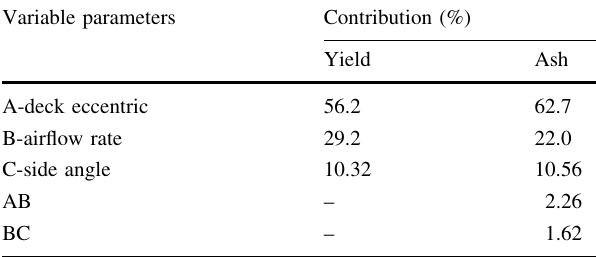
Table 5 Variables contributing towards the responses Variable